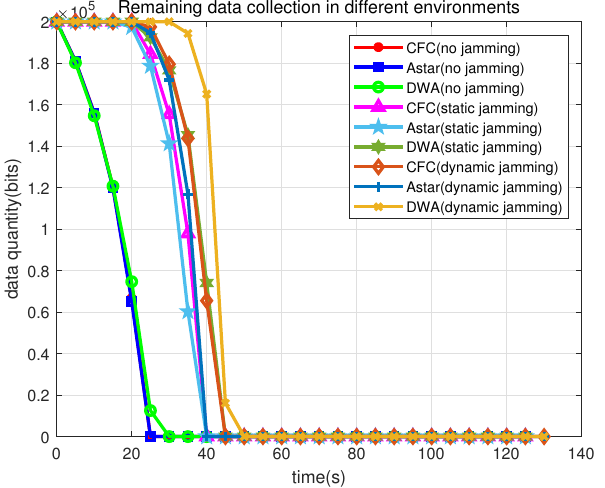
Figure 7. The residual amount of data collected for three algorithms in different environments.